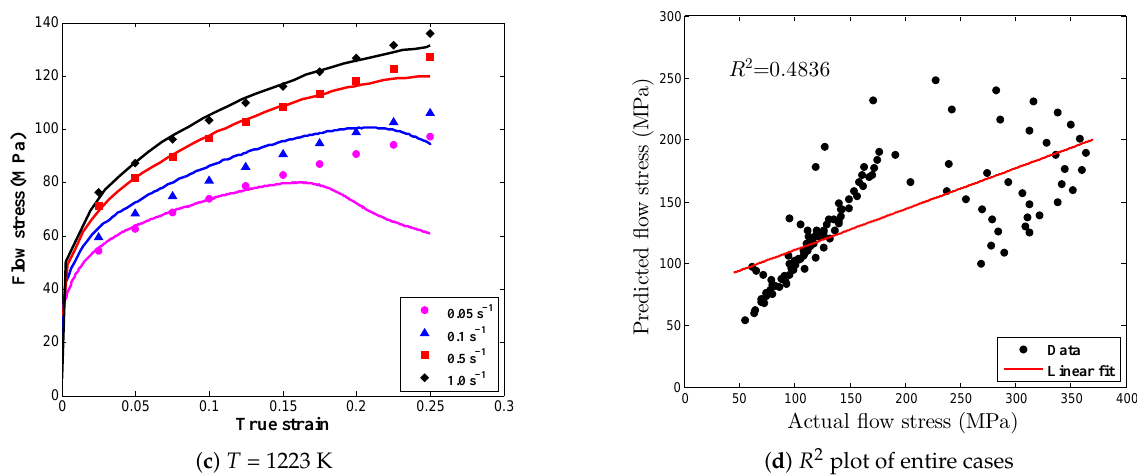
Figure 11. Comparison between experimental and predicted flow stress data using the modified Johnson-Cook model.